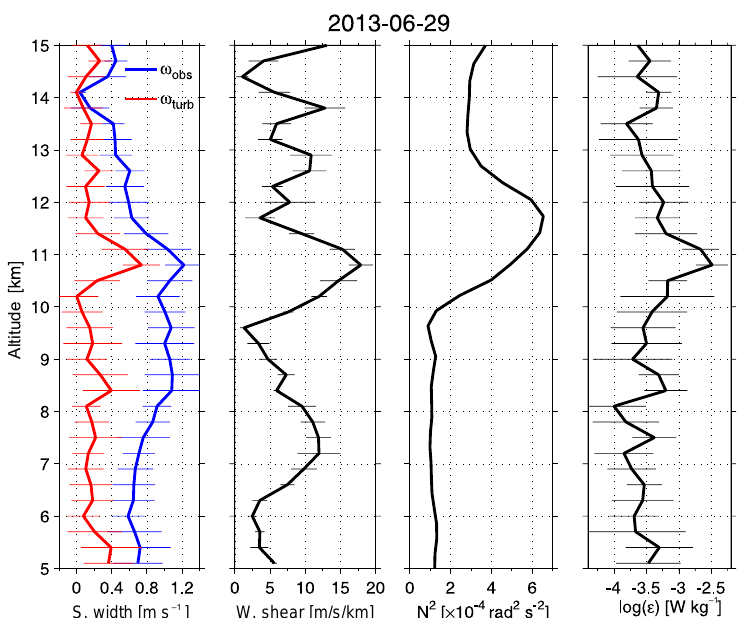
Figure 3. Profiles of spectral width ( ω obs and ω turb ), wind shear derived from radar observations with MAARSY, and turbulent energy dissipation rate converted from ω turb (mean values and standard deviations) over the period of 1h, straddling the time of the radiosonde ascent on 29 June 2013 (the flight began at 16:12; see Fig. 4) in the first, second, and fourth panel from left, respectively, and the squared Brunt–Väisälä frequency ( N 2 ) derived from the ECMWF reanalysis data averaged over 1 day on 29 June 2013 in the third panel from